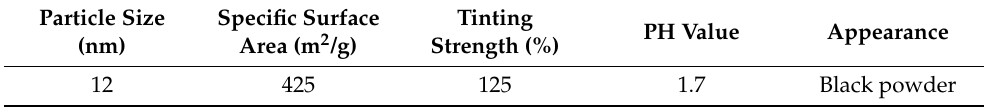
Table 1. Basic technical properties of toner.